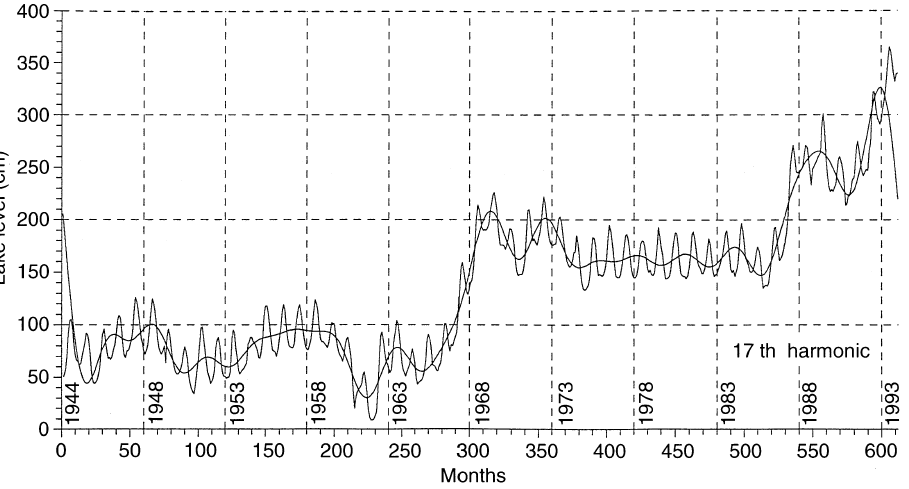
Fig. 3. Van Lake level fluctuation record from 1944 to 1994